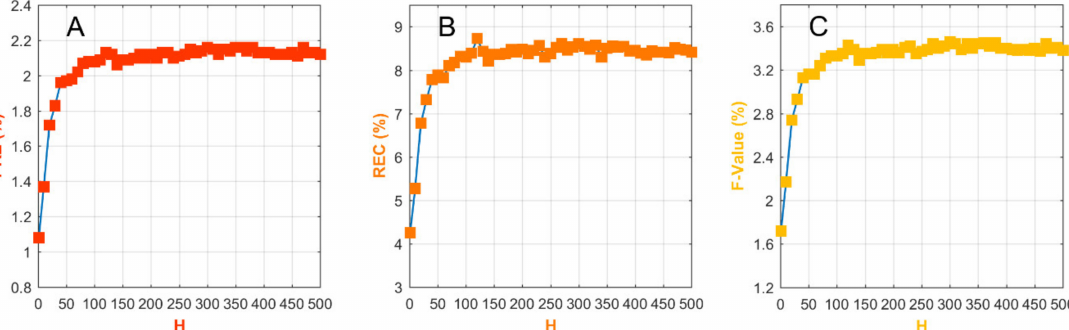
Figure 7. Influence of di ff erent values of the memory attenuation index H on recommendation performance (at a rank cut-o ff value of L = 10). ( A ) Precision with di ff erent H values. ( B ) Recall with di ff erent H values. ( C ) F-value with di ff erent H